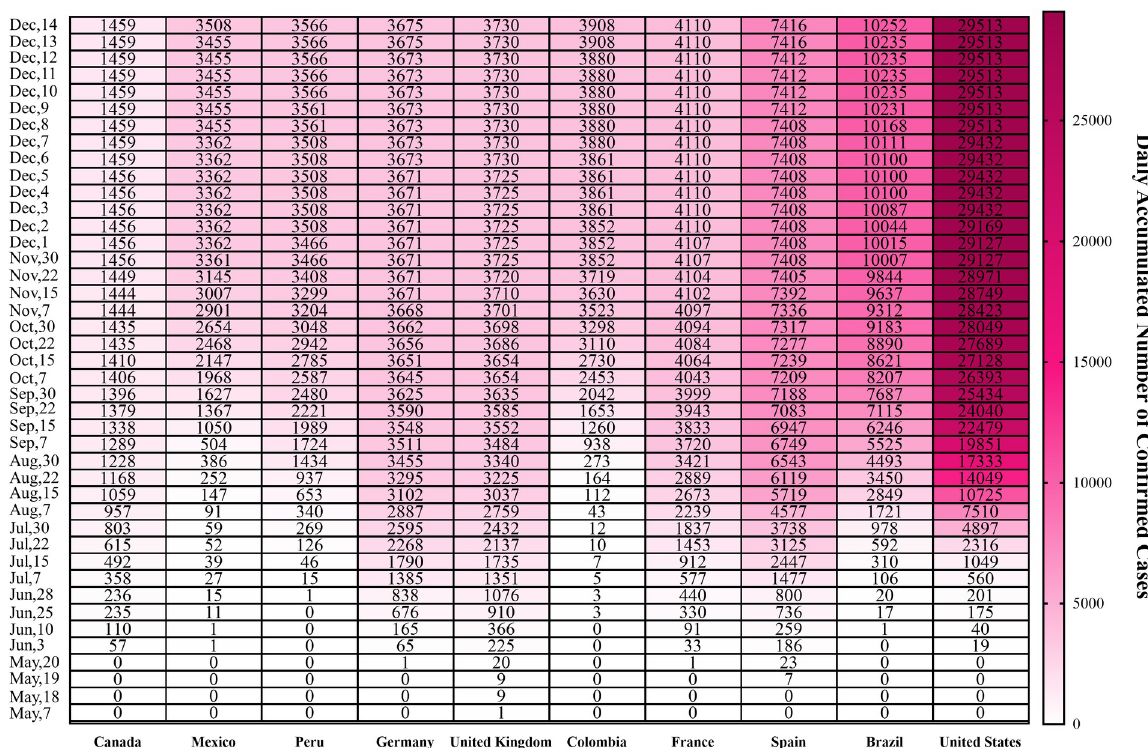
Fig 2. Cumulative confirmed cases, by date of confirmation in countries with total confirmed cases ranking top 10 till December 14, 2022. https://doi.org/10.1371/journal.pntd.0011246.g002 relatively less pathogenic in the host and can only cause a subclinical level of infection. How- ever, zoonotic infections are usually highlighted only after species transfer, which increases viral pathogenicity or generates novel diseases. Tissue and host tropism majorly influences the ability of a virus to spread among hosts. These 3 levels of tropism are highly interdependent in terms of determining whether it possesses the ability to infect the host. There exists a wide range of genera, species, families, and orders of mammals affected by MPX [8,9], suggesting a wide host tropism of MPX ( Table 1 ). Meanwhile, high levels of viral DNA were monitored in the eyes, oral and nasal cavities of MPX-infected animals, suggesting that MPX has a wide tis- sue tropism. The members of the genus OPV have different host tropism profiles; this variabil- ity may enhance the host–virus interactions, reduce pathogenicity, and distinguish the immune evasion molecules.